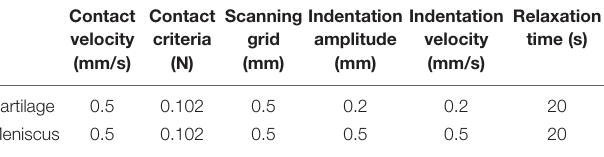
TABLE 2 | Setup data to perform the biomechanical mapping of the cartilaginous (femur and tibia) and meniscus